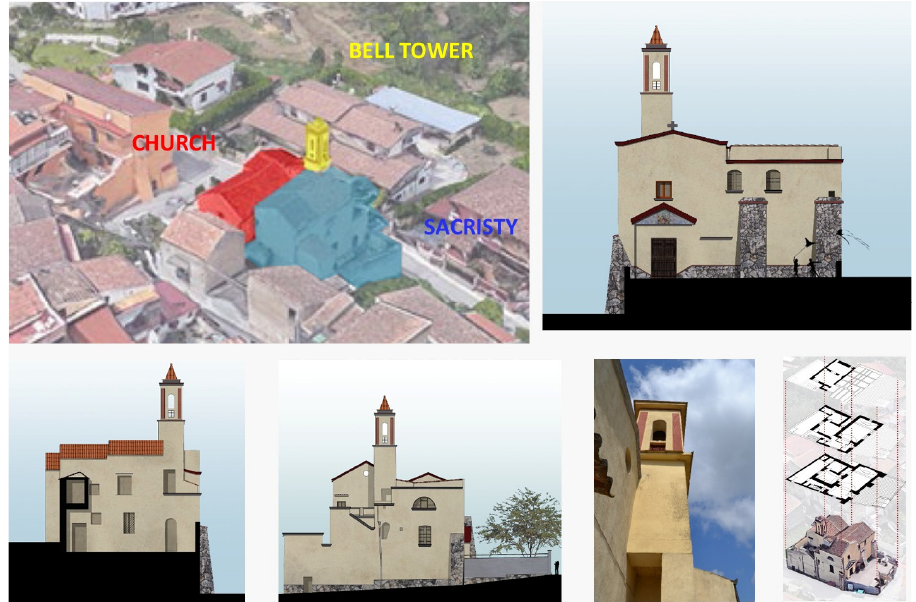
Figure 4. The case study: the ecclesiastical complex of S. Anna in Cervino. The bell tower has an overall height of 17.20 m (h 0 ). Its base is placed on a pillar at an altitude of 7.40 m (h 3 ) and is adjacent to the external wall of the sacristy for 2.30 m (h 2 ) (Figure 5).